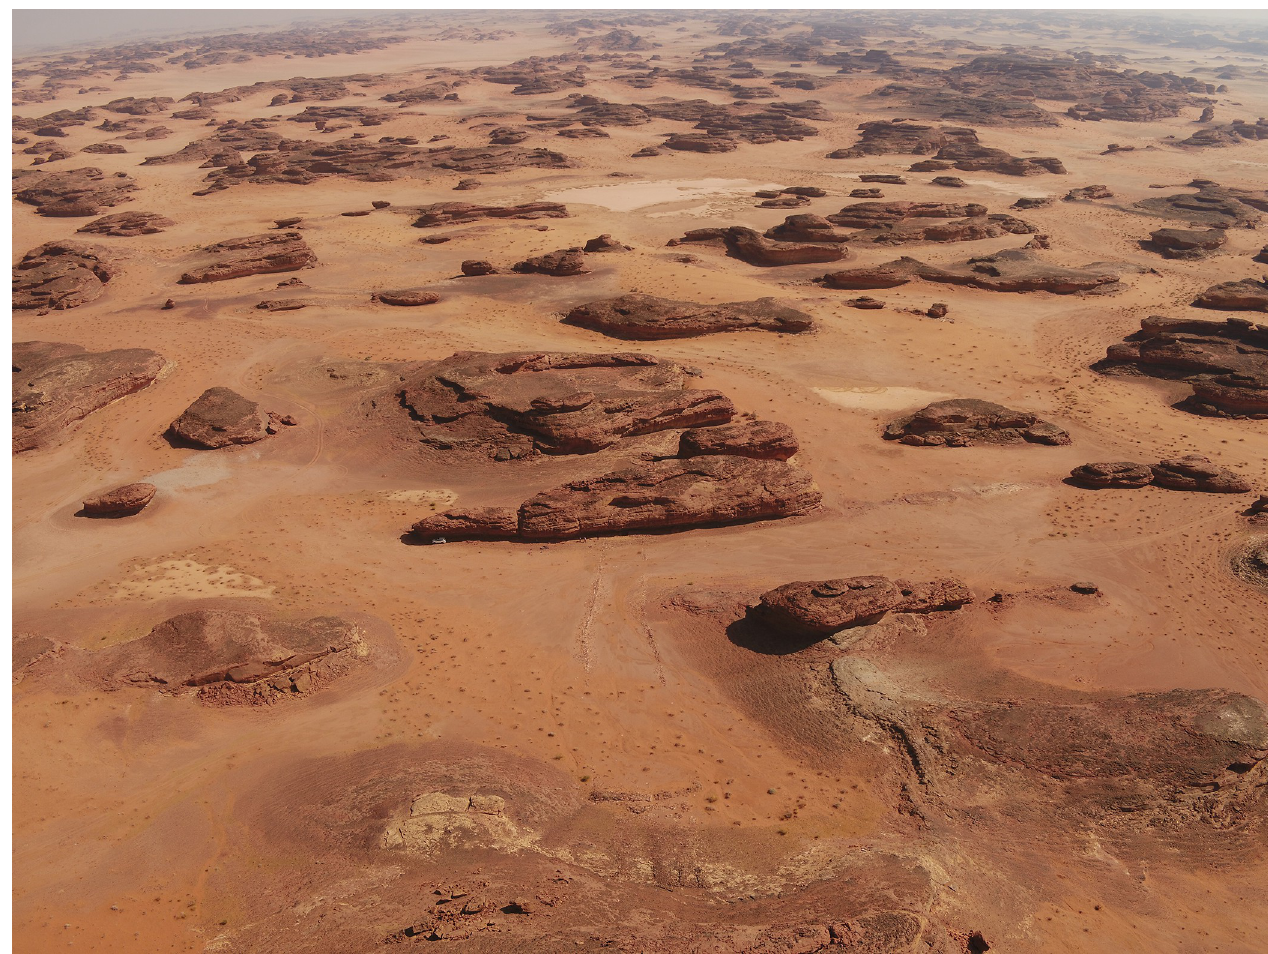
Fig 28. Mustatil IDIHA-F-0011081 orientated (head) towards a playa located to the east, photo orientated east.